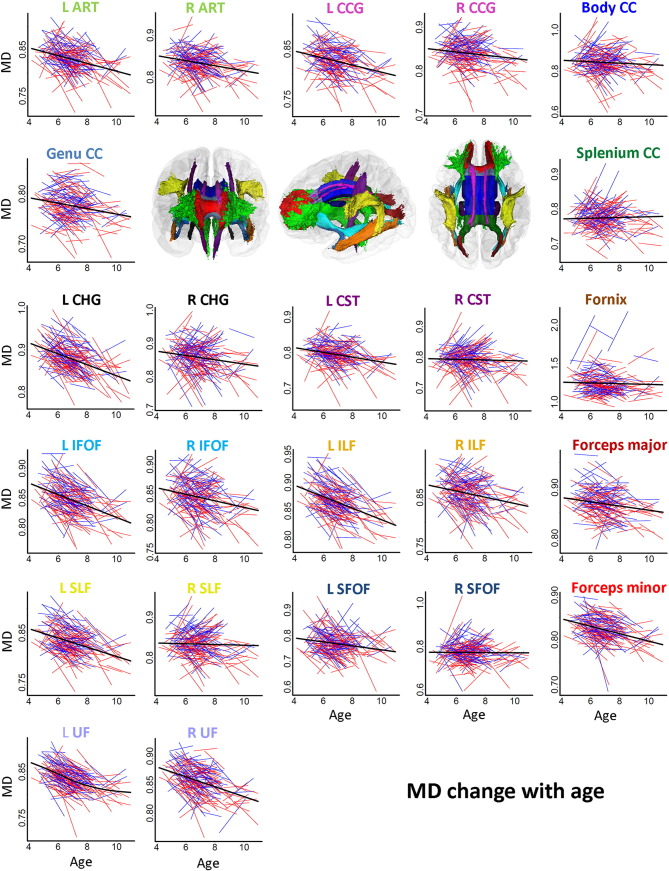
Spaghetti plots of change for MD in specific tracts with age.Spaghetti plots of individual participant change in MD in specific tracts with age (years). Females are plotted in red and males in blue. For each measure, an assumption-free general additive mixed model as a function of age was fitted to accurately describe changes across the age range. Diffusivity values for MD are in 10− 3 x mm2/s. Diffusivity values for MD are 10− 3 x mm2/s. Three-dimensional renderings of the probabilistic tracts illustrate fifteen atlas-based probabilistic tracts from the Mori atlas as for Fig. 3.